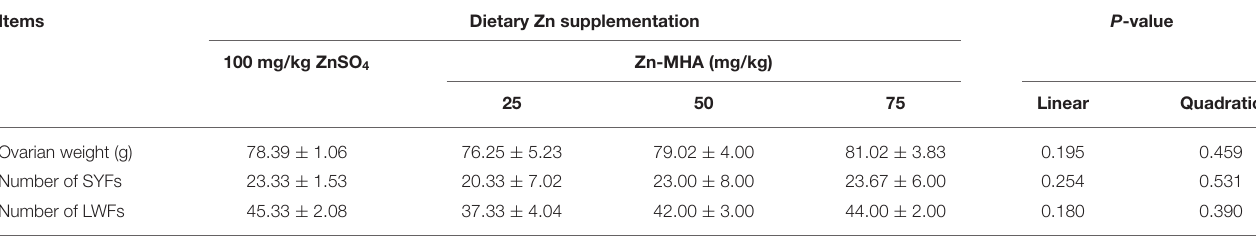
TABLE 7 | Effects of dietary Zn-MHA supplementation on ovarian development in broiler breeders a .